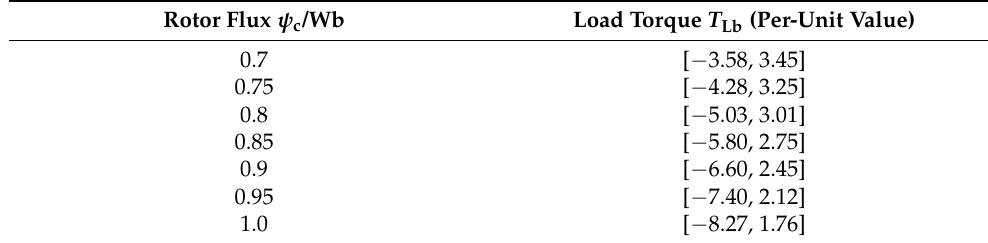
Table 2. The upper and lower boundaries of load torque at speed of 1500r/min.